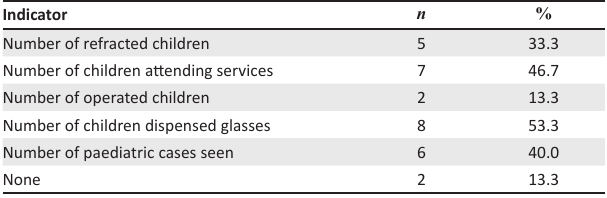
TABLE 2: Eye health practitioners who reported indicators used to monitor paediatric services and programmes.